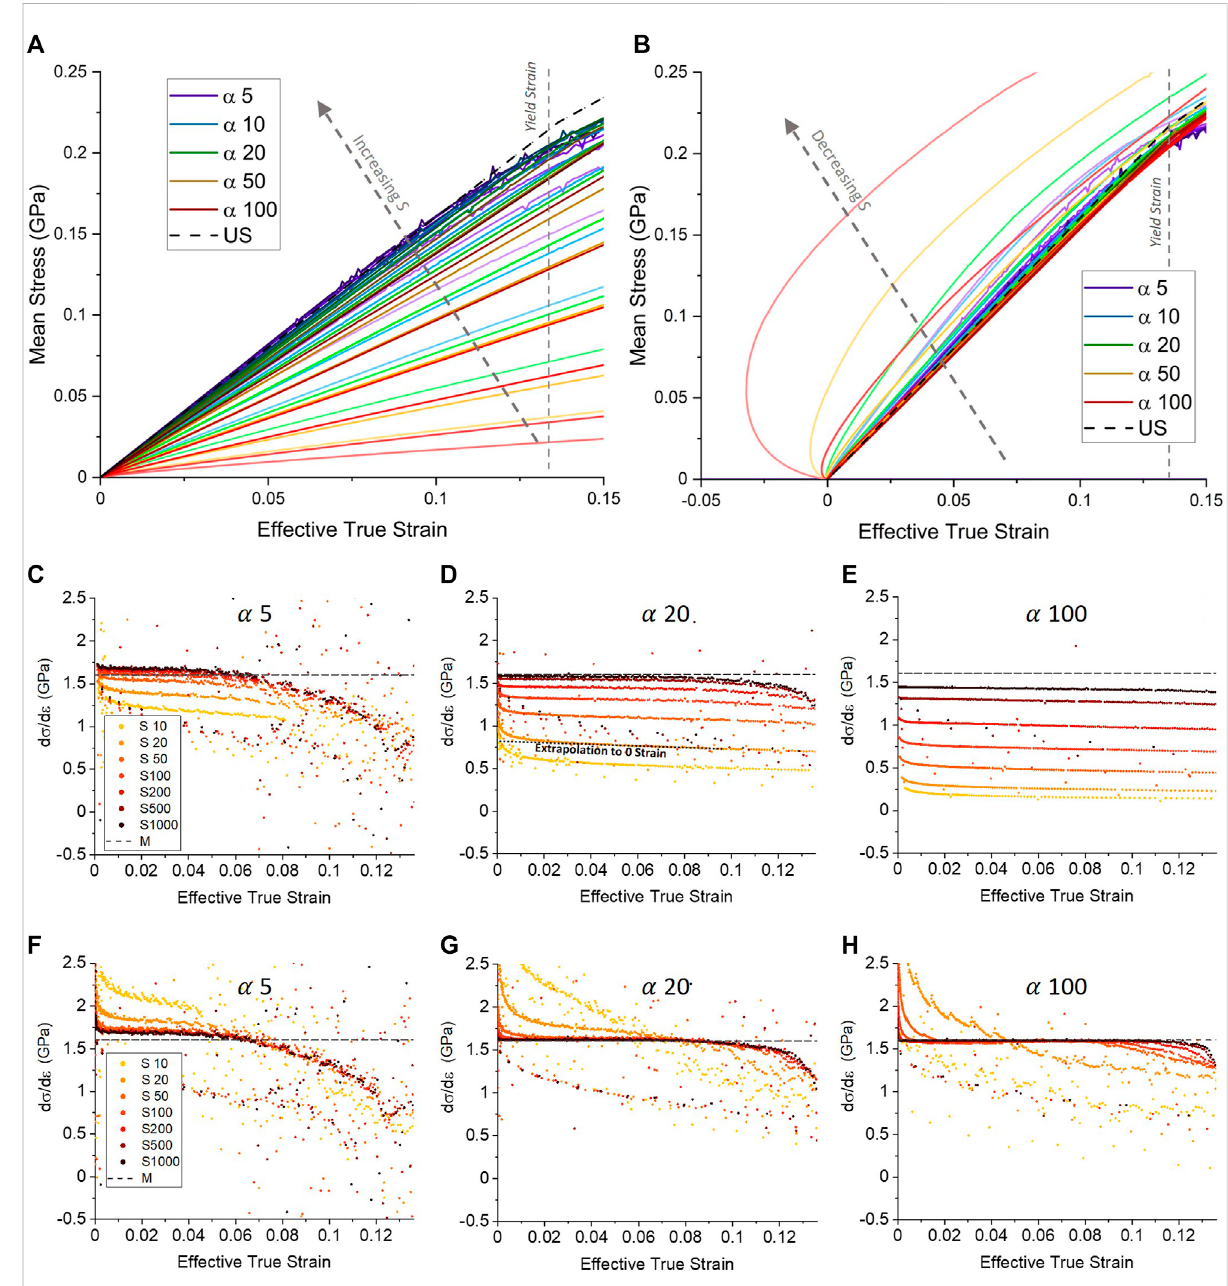
Effect of varying contact aspect ratio α and substrate-to- fi lm modulus ratio S on mean stress vs. effective true strain in the layer compression test simulated for a 1 μ m radius fl at punch in frictionless contact with thin elastic-plastic fi lms bonded to an elastic substrate. (A) Mean stress vs. effective true strain ε =-ln [( h 0 -h ) /h 0 ] values for all S and α simulated, with no correction for elastic substrate deformation. The legend shows colour trend of α values, and the trendline insert shows the trend of S within the α subgroups, with darker shades of a given colour representing higher values of S . Numerical artefacts from the FEA simulation cause a slight sawtooth pattern in some curves, though this does not correspond to a physicaleffect. (B) Dataof (A) withsimplecorrectiontoremoveeffectofsubstratebending(seemaintext). (C – E) Calculatedslope d σ / d ε vs.effective true strain of data in (A) up to yield strain showing details of scaling with S for a selection of aspect ratios. A good approximation to the con fi ned modulus M is found at low strain for experimentally accessible aspect ratios α = 5 – 20 when on stiff substrates. This breaks down however at high aspect ratios, or if S is not suf fi ciently high. If a lower S is used, a substrate correction step should be considered. (F – H) Provides d σ / d ε curves as in (C – E) but with substrate correction of (B) . Residual deviations from the expected M value at low S (particularly 10 and 20) are due to limitation of the simple substrate correction which does not account for non-uniform substrate bending strains or effects of the rounded punch contact area. Overall, the simple correction for substrate bending allows for excellent determination of M with values of α and S (eg. α = 20 and S = 50) that are generally experimentally